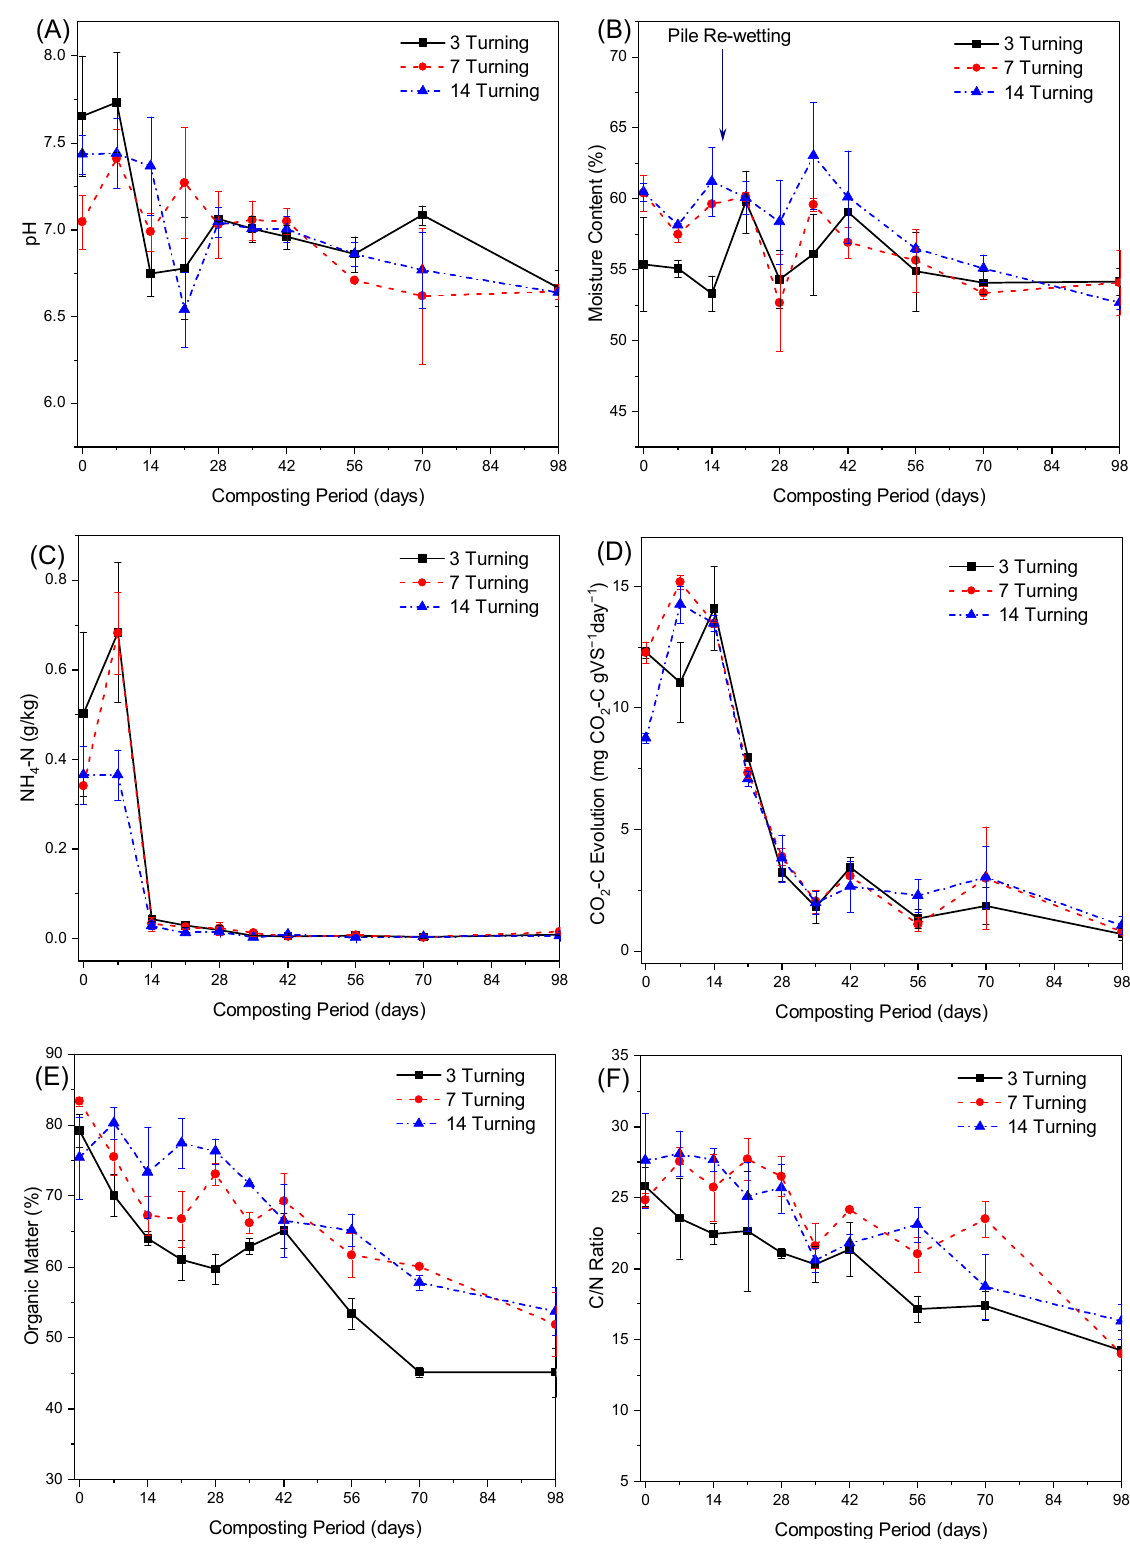
Figure 2. Evolution of ( A ) pH, ( B ) Moisture Content, ( C ) Ammonia nitrogen (NH 4+ -N), and ( D ) Carbon dioxide (CO 2 -C) respiration rate, ( E ) Organic matter, and ( F ) C/N ratio during Fecal Sludge (FS) composting with sawdust using 3 days turning frequency—3 Turning, 7 days turning frequency—7 turning, and 14 days turning frequency—14 turning. Error bars represent the standard error of n = 2.